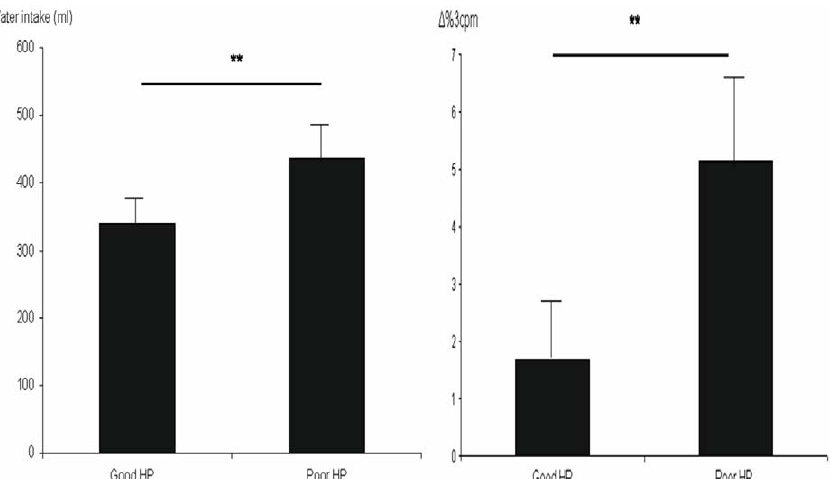
Figure 3. Water intake (ml) in good and poor heartbeat perceivers (**: p , .01), good HP = good heartbeat perceivers, poor HP = poor heartbeat perceivers (3A); Normogastric reactivity (% 3 cpm) in good and poor heartbeat perceivers during/after WLT (**: p , .01); % 3 cpm is percentage of the 3 cpm activity (2.5-3.5 cpm) relative to the total power (3B).